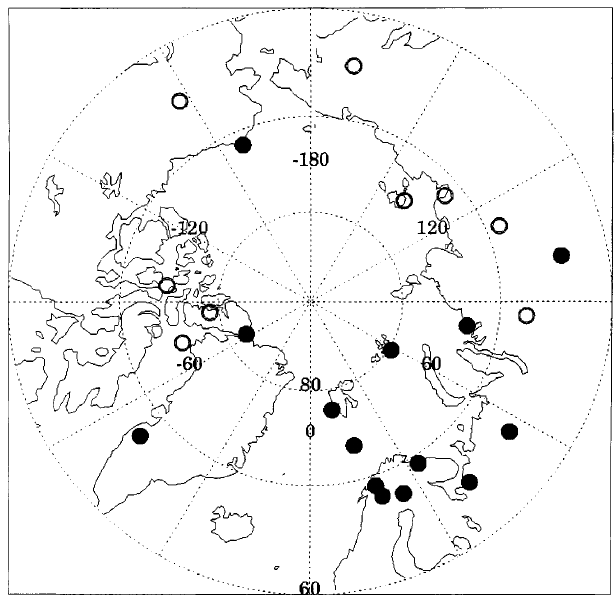
Fig. 3. Main geophysical observatories in the northern polar cap used to examine the di(cid:128)erence of the total ozone after and before the REP events. The solid circles mean the ozone decrease, the open circles mean a positive di(cid:128)erence